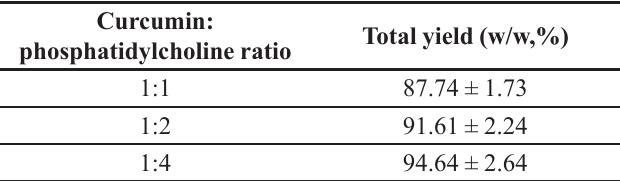
TABLE I - Total yield of phytosome preparation process Curcumin: